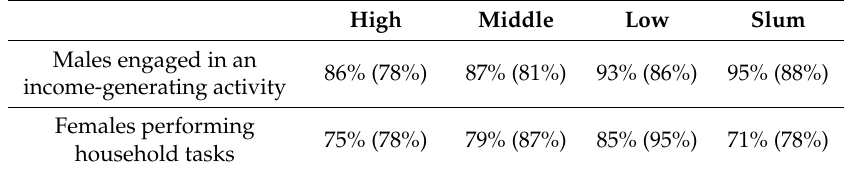
Table 4. Proportion of people engaged in typical activity, classified by gender and income